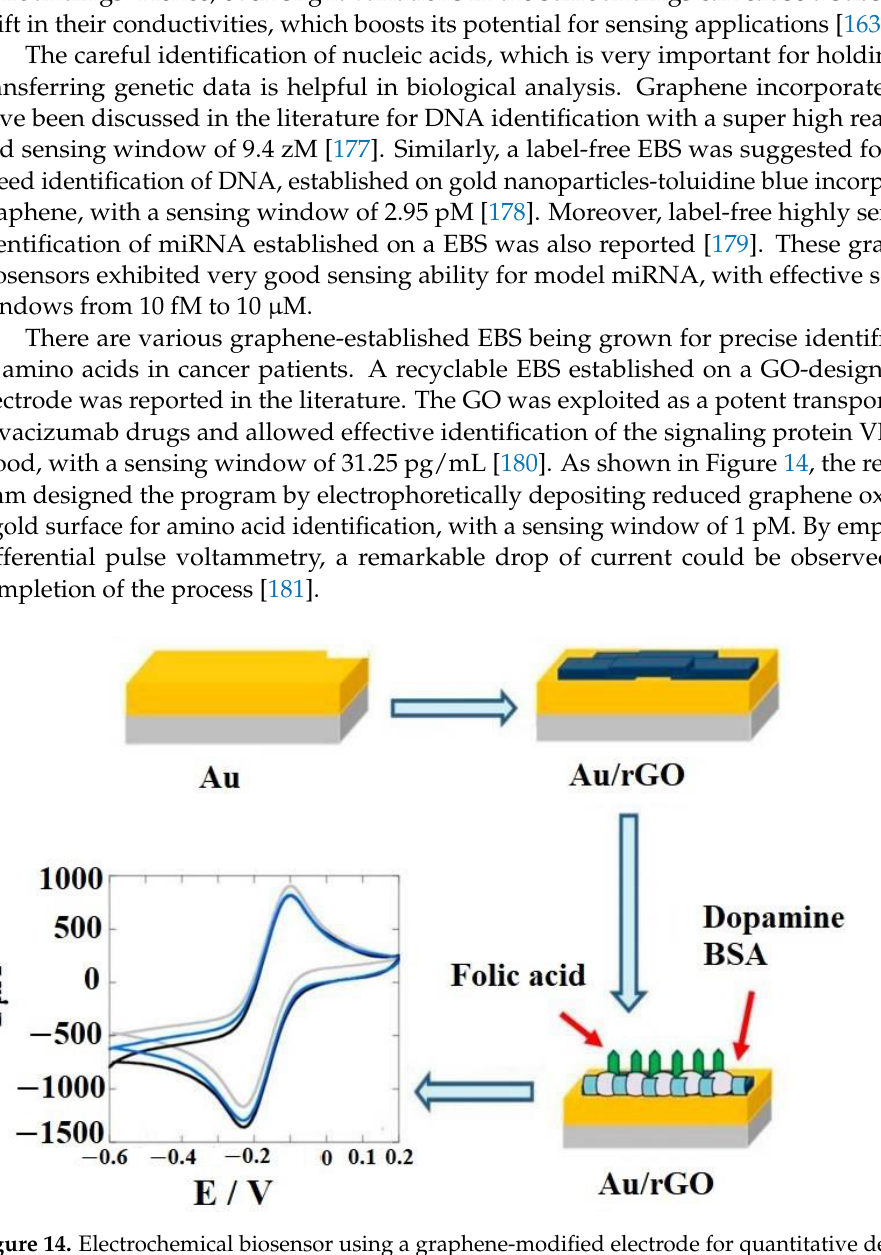
Figure 15. Graphene-based electrochemical biosensor for detection of folic acid. Reproduction re- quires permission [182]. Copyright 2016 Springer. Although there have been many reports about graphene biosensors in the literature having reasonable stability and reproducibility, the results of some biosensors with bio- samples (e.g., urine, blood, etc.) are not satisfactory in their detection level, due to the non-